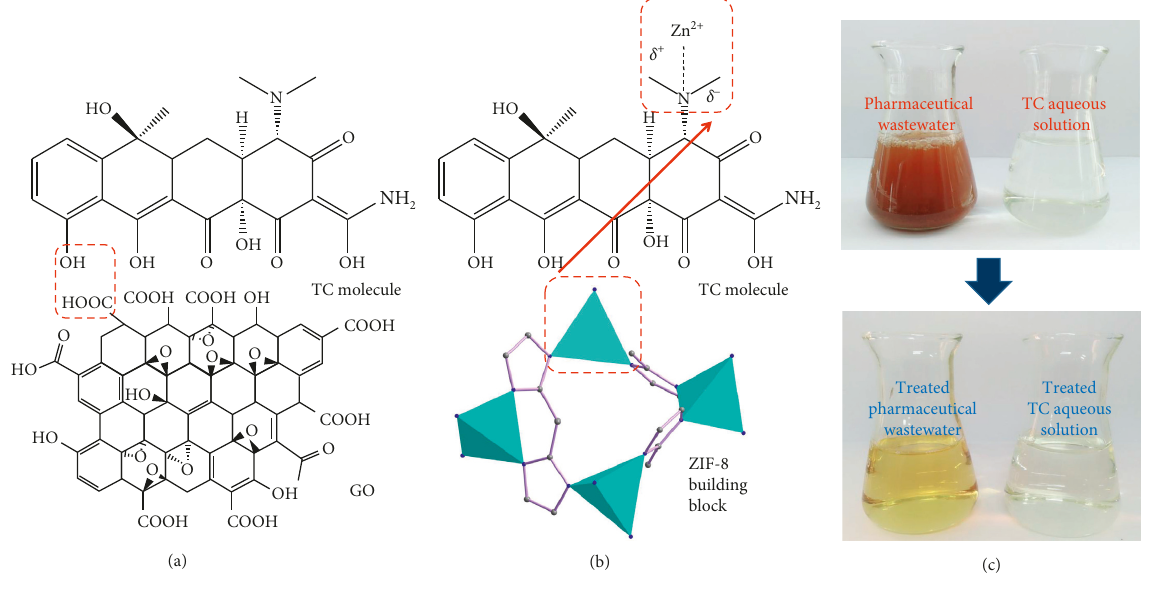
Figure 11: Proposed adsorption mechanism. Table 5: Comparison of adsorption parameters.